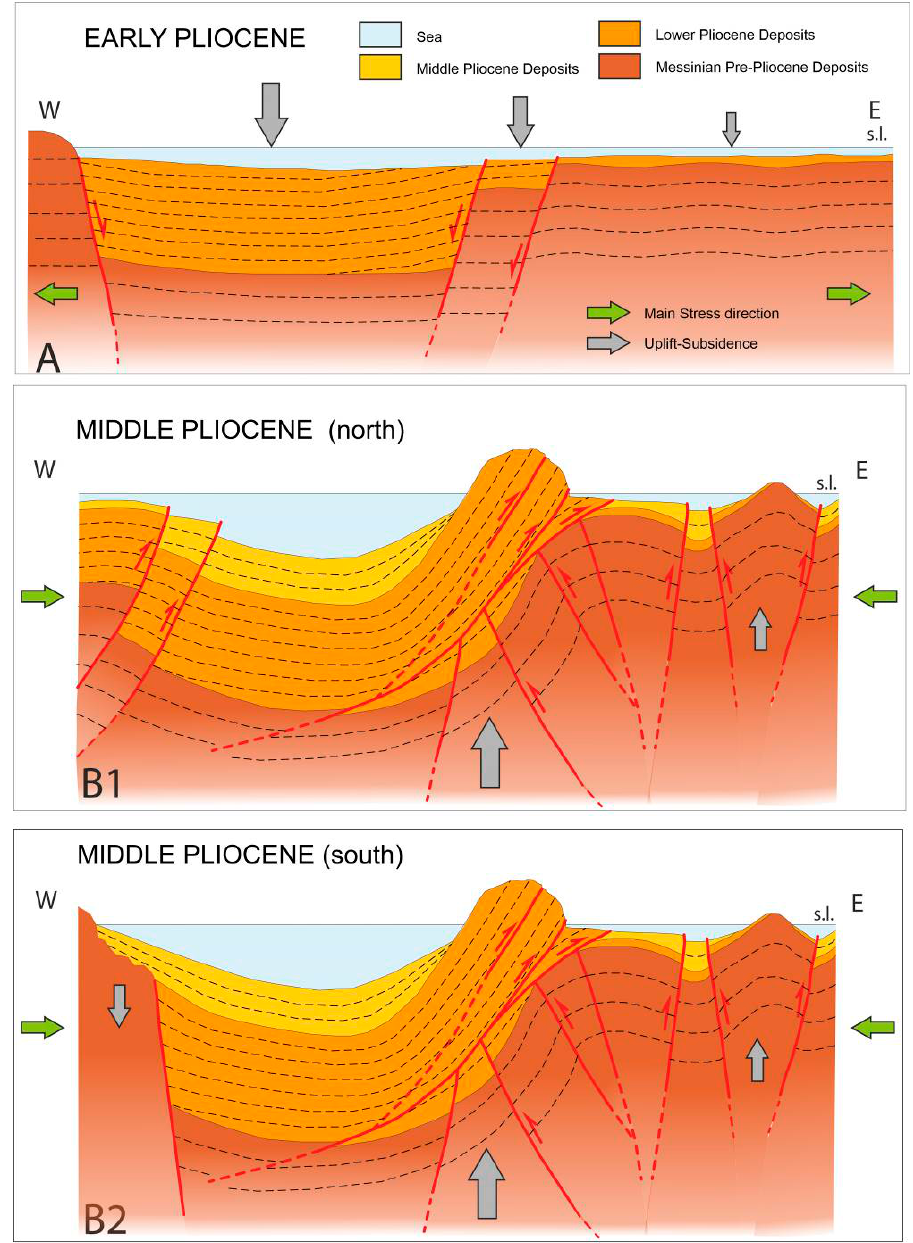
Figure 11. Sketch diagram showing the evolution of the Coastal Structure from the Early to Middle Pliocene across two representative cross-sections (not to scale). The size of the grey arrows is pro- portional to the intensity of vertical movement.